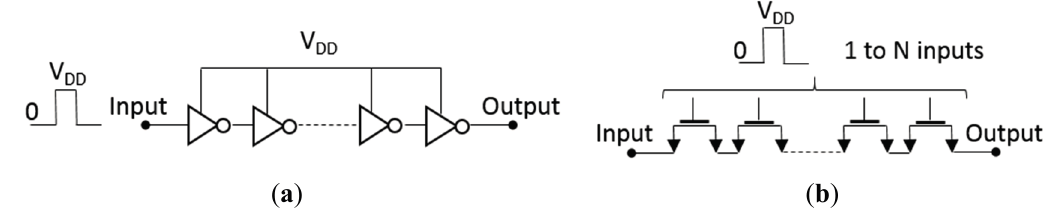
Figure 9. Illustration of digital signal propagation delay in optimally designed ( a ) complementary metal-oxide-semiconductor (CMOS) logic circuit, ( b ) NEM relay-based logic